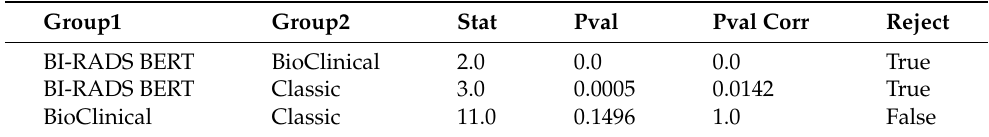
Table A20. Bonferonni-corrected McNemar test results for field extraction with no section segmenta- tion of density.